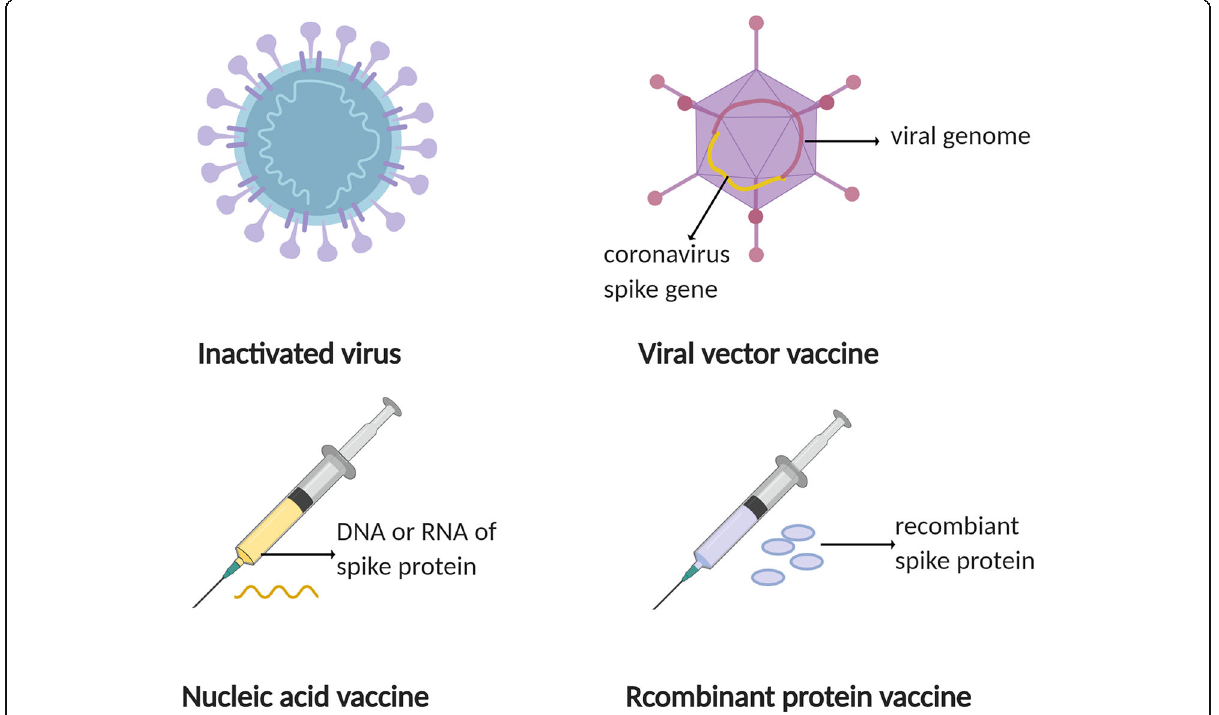
Fig. 3 Strategies for development of vaccines. The spike glycoprotein is a key target for vaccine design due to its indispensable function in recognition of host cells and mediating fusion of the virus with cell membrane. Inactivated vaccine: to make sure the safety of inactivated vaccines, the virus was treated by chemicals, such as formaldehyde or heat. Viral-vector vaccine: The adenovirus is usually a preferable choice for vaccine vector. The vector was genetically modified to produce spike protein of SARS-CoV-2. Of note, the virulence of viral vector was weakened so it would not cause disease. Nucleic acid vaccine: Following the injection of DNA or RNA of spike protein, nucleic acids were inserted into human cells, synthesizing copies of spike protein. Recombinant protein vaccine: Genetic segments of target antigen were selected and recombined into an expression system. The recombinant spike protein was prepared in vitro and purified for further